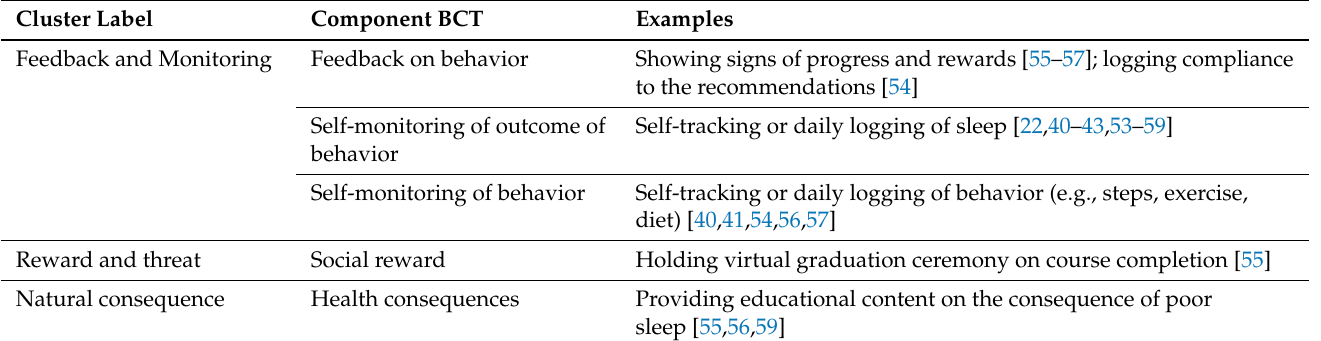
Table 6. BCTs focusing on future outcomes of sleep or consequences of poor sleep (Category-II BCT).